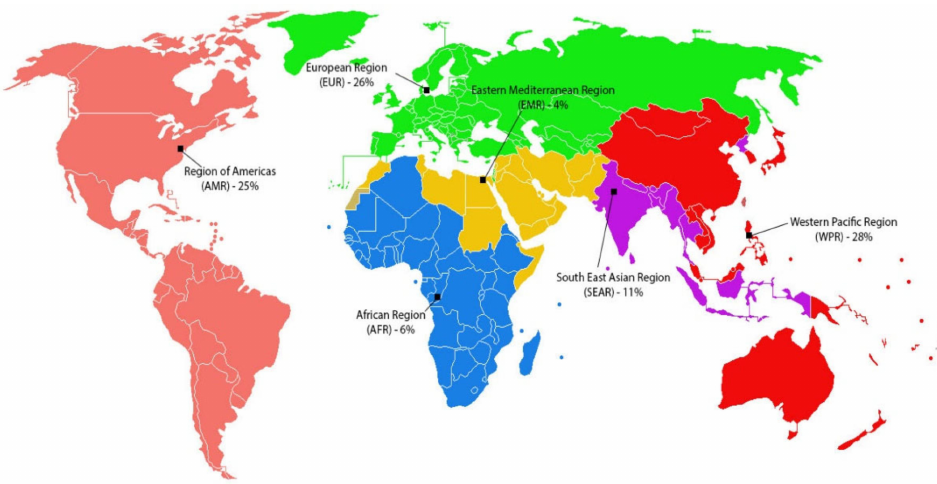
Figure 4. Review articles by WHO regional